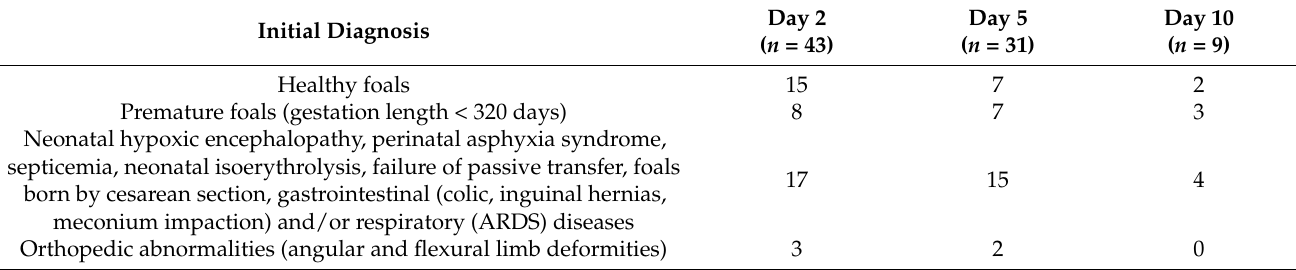
Table 1. Number of foals at the different time points of the echocardiographic exam, with their initial clinical diagnosis; (ARDS: acute respiratory distress